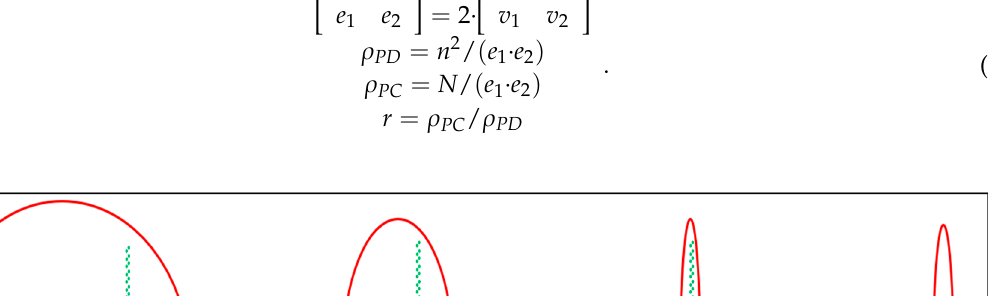
Figure 15. Example of increasing the number of probability distributions.